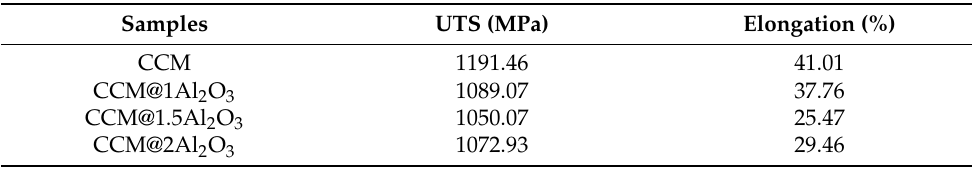
Table 4. Tensile properties of the LPBF-processed